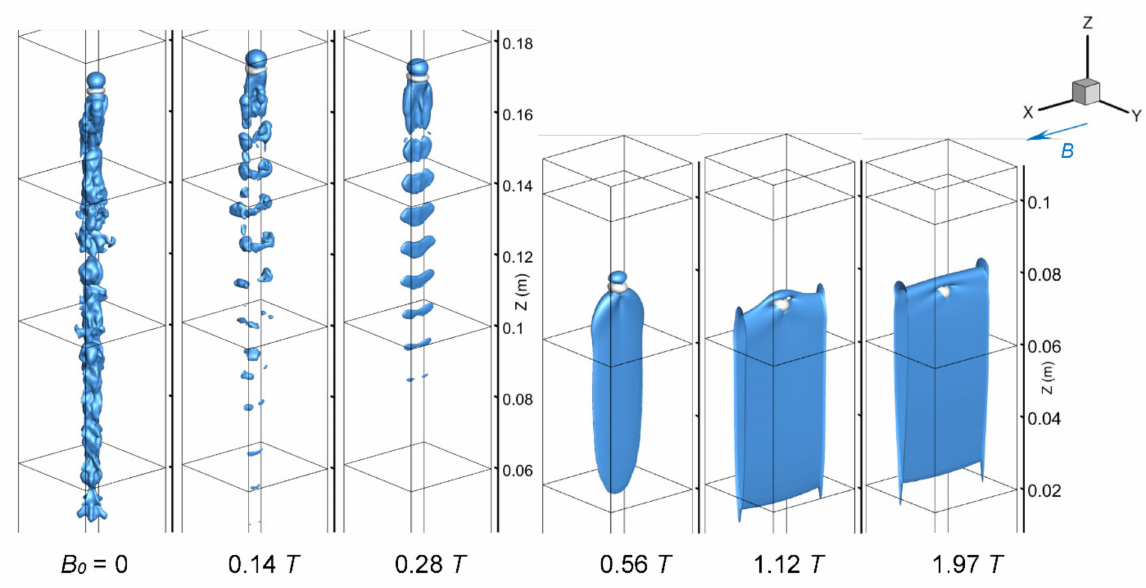
Figure 17. Three-dimensional image of the iso-surface | u rel ∗ | = 0.9. The wake is apparently broader in the x -direction for higher B 0 ( ≥ 1.12 T) (see Video S1).